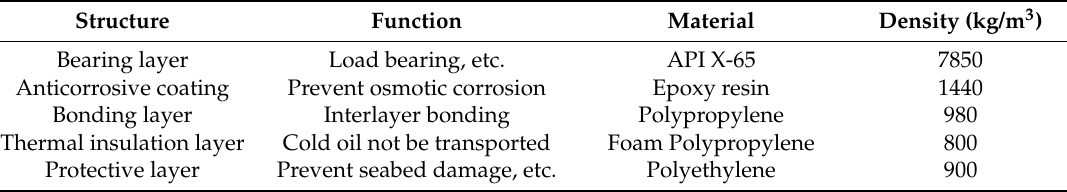
Table 1. Structure layers of the SCR bonded riser.